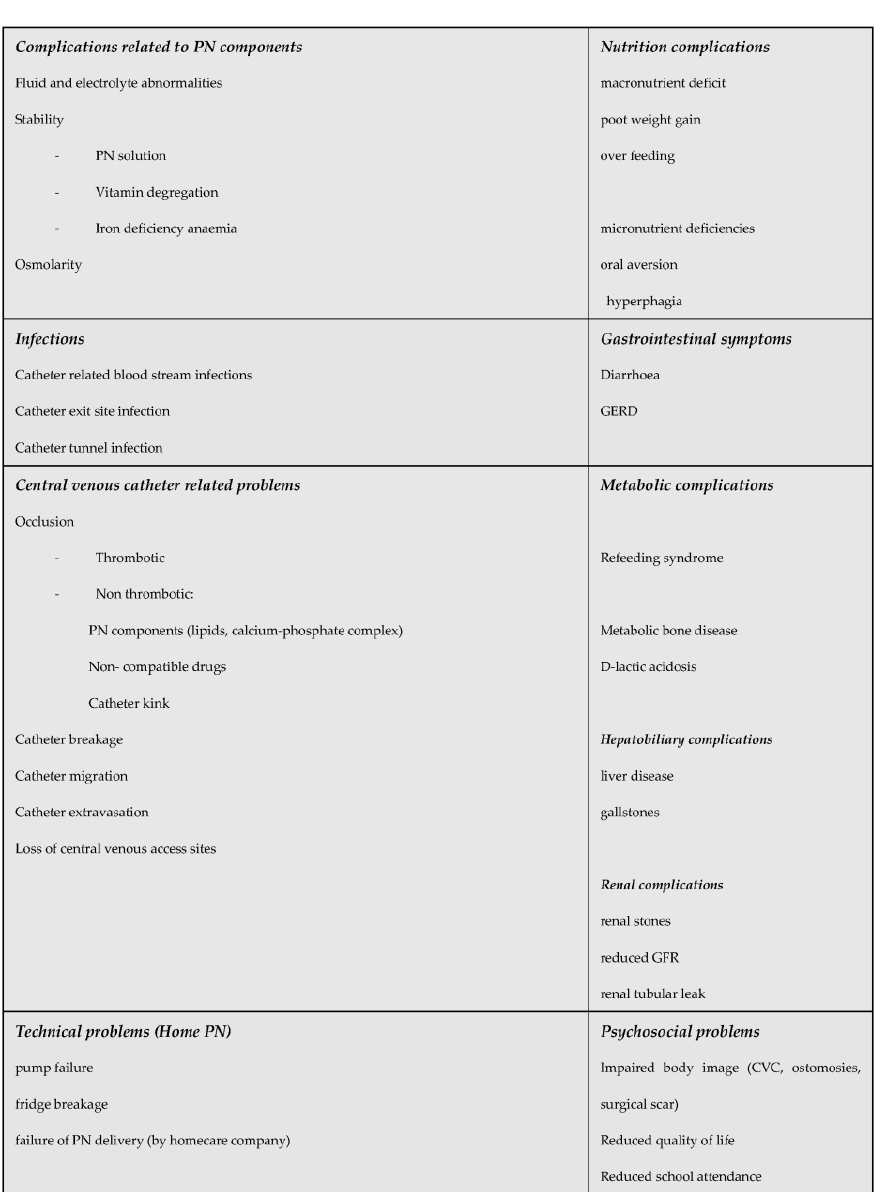
Figure 2. Complications of children with SBS receiving long term parenteral nutrition.